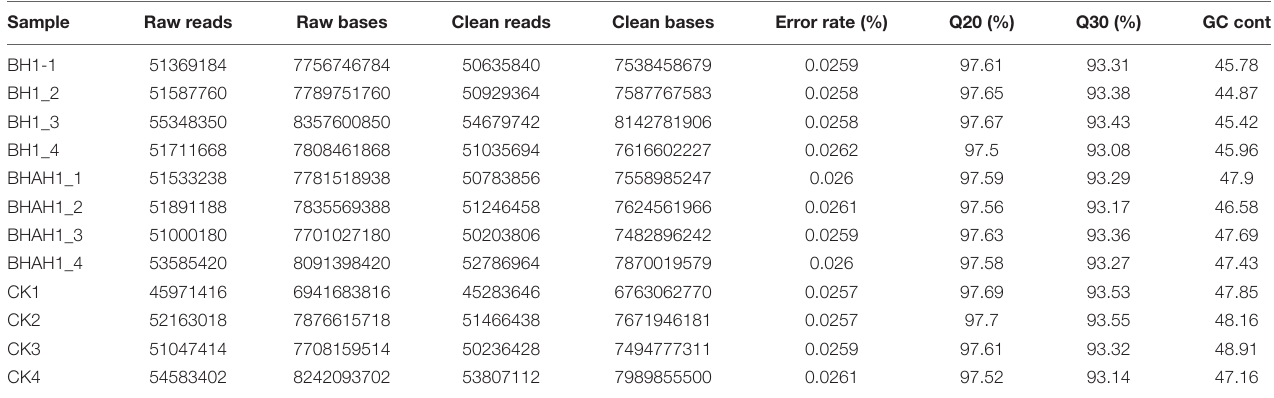
TABLE 2 | Transcriptome sequencing data in gill tissues of C. japonica